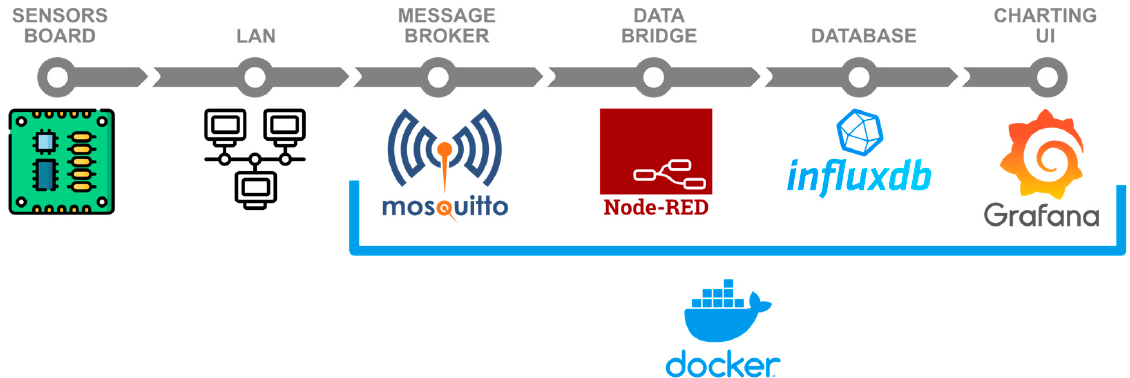
Figure 5. Block diagram of the end-to-end datapath.